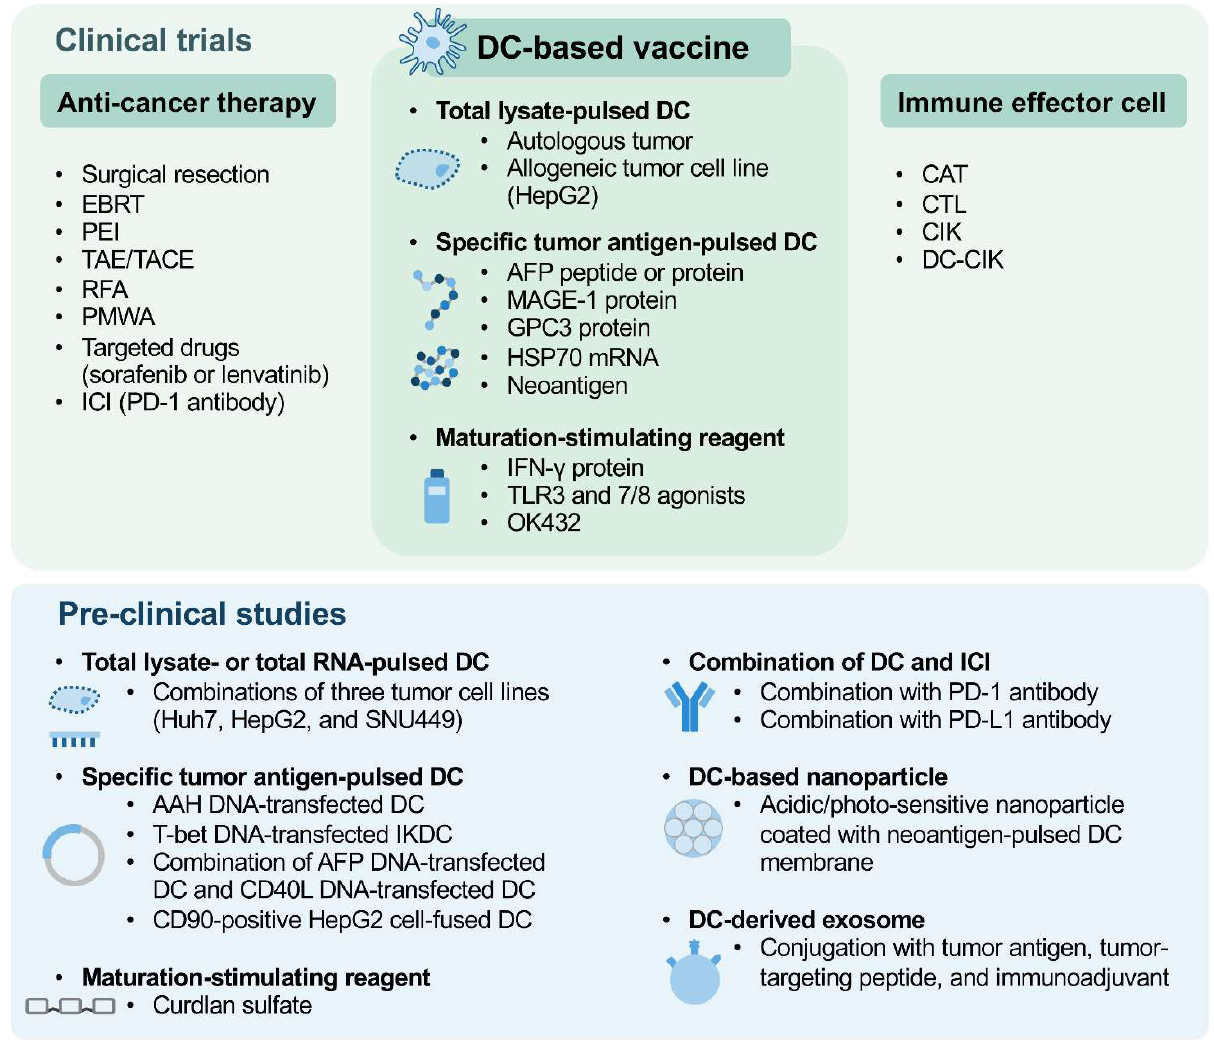
Figure 1. Schematic summary of clinical and preclinical strategies of DC-vaccine-based immunotherapy for HCC.